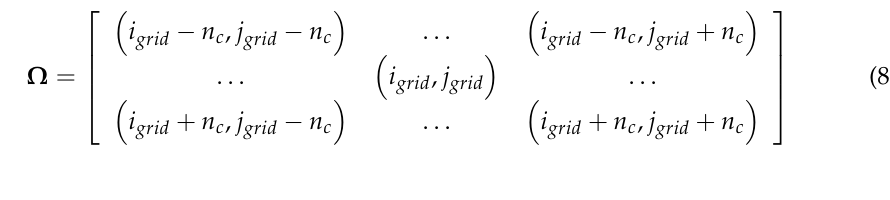
n is determined by the search radius c